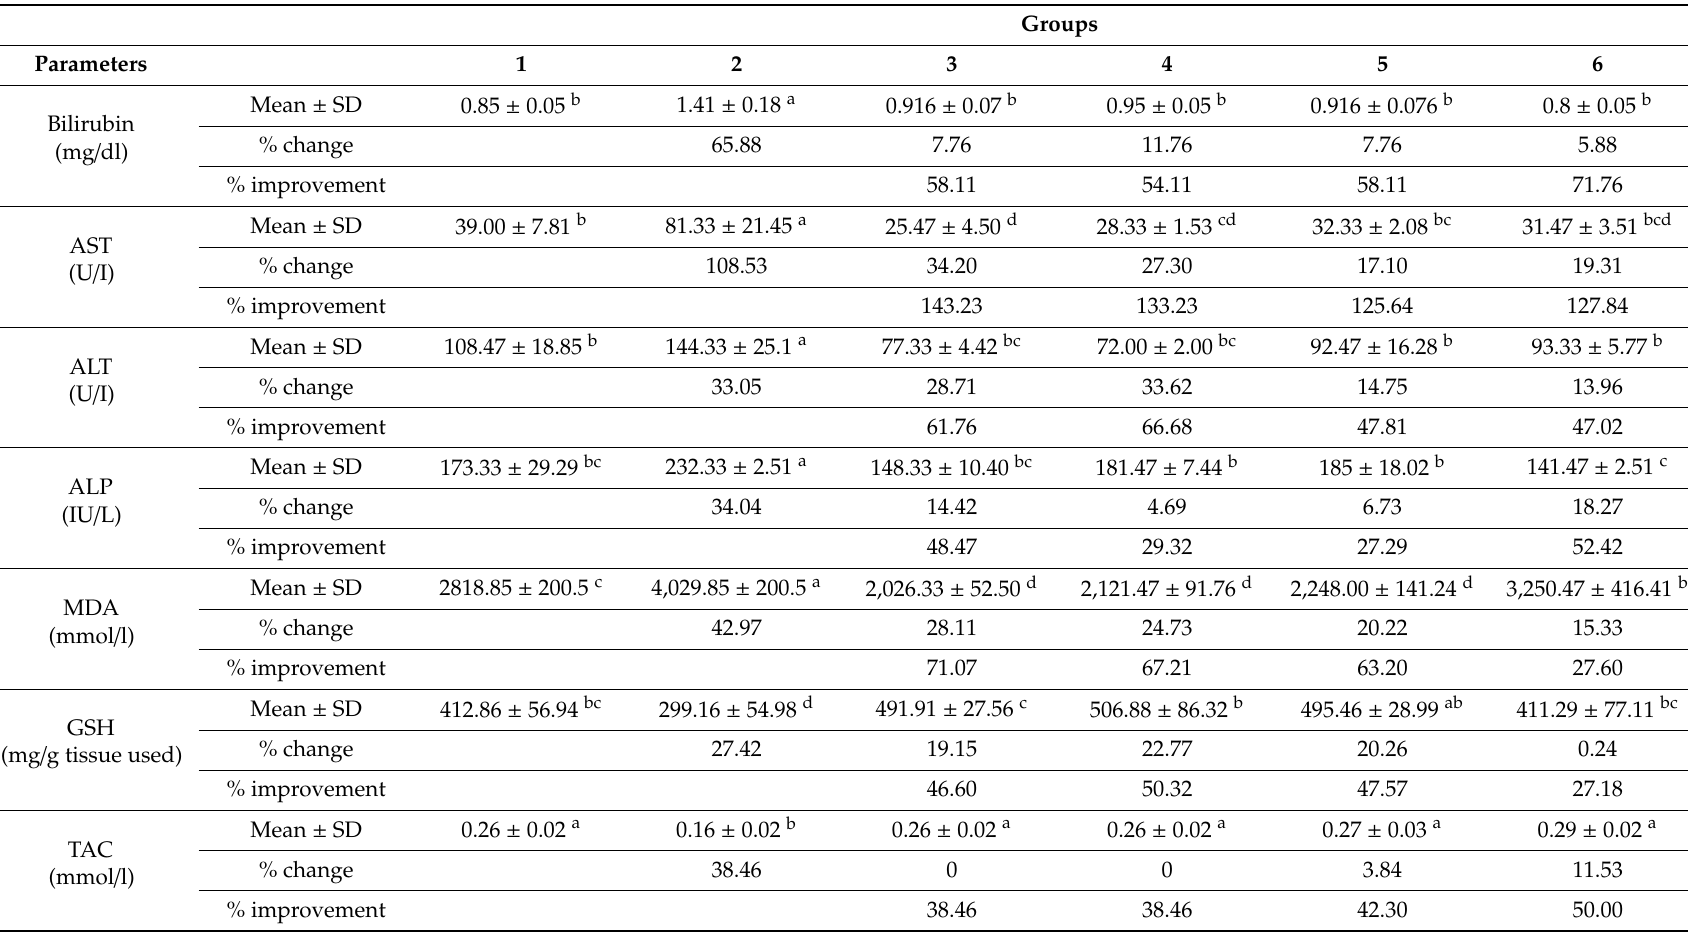
Table 4. Results of the liver function, oxidative stress marker, antioxidant, inflammatory marker, and adhesion molecule tests measuring the activity of the Premna odorata crude, defatted, and n-hex extracts induced in alcohol-inflamed liver female Wistar albino rats according to Keegan (2013) [23] using a dose of 500 mg / kg b.w. for thirty days who were then euthanized (silymarin was used as a reference drug using a 200 mg / kg b.w.